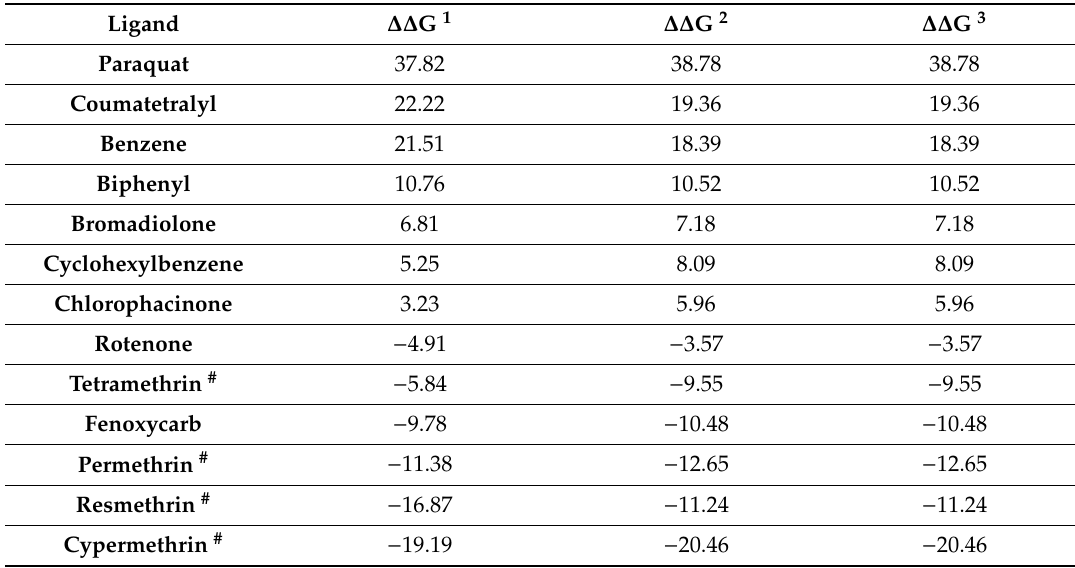
Figure 5. A heatmap of the absolute Δ G calculated from MMGBSA for the 12 simulated pesticides and the negative control, benzene, in triplicate ( A , B and C ). The highest affinities are shown at the bottom. Table 3. The ΔΔ G between the pesticides and palmitate from MMGBSA repetitions.